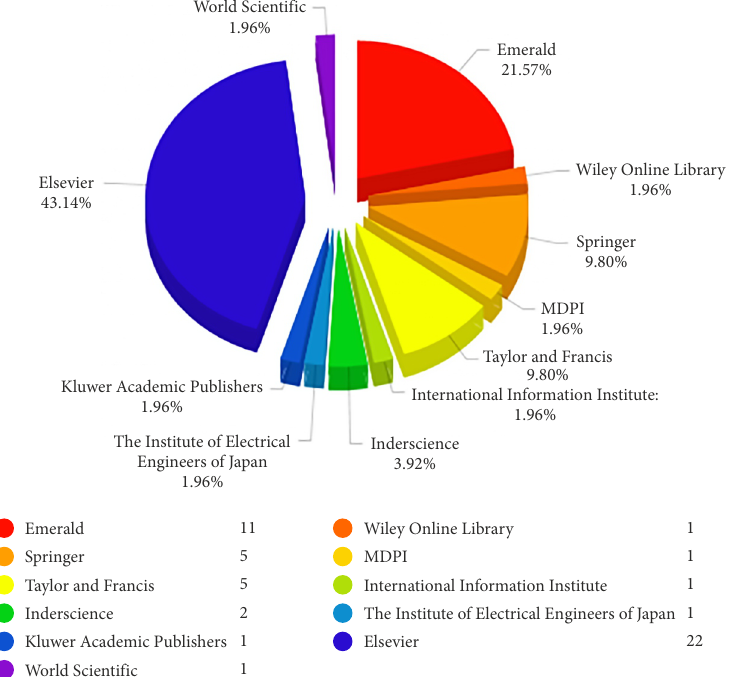
Figure 4. Percent of Benchmarking-DEA articles with regard to various